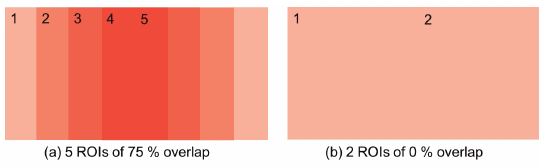
Figure 7. Same areas with difference overlaps of